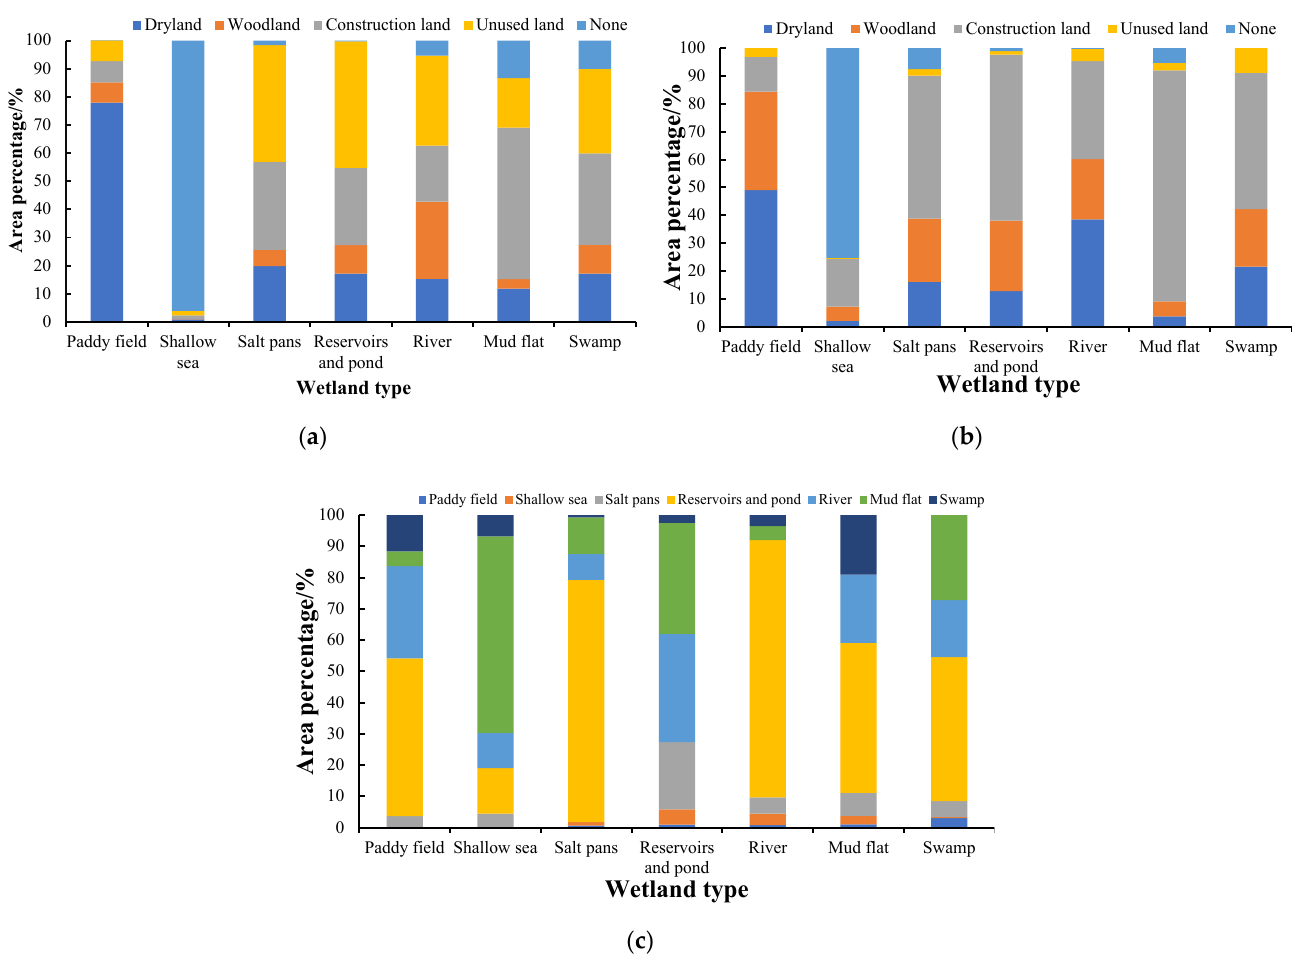
Figure 9. Area proportion of different wetland types. ( a ) Area proportion of sources for new-born wetlands; ( b ) Area proportion of land uses for extinction wetlands; ( c ) Area proportion of internal conversion among